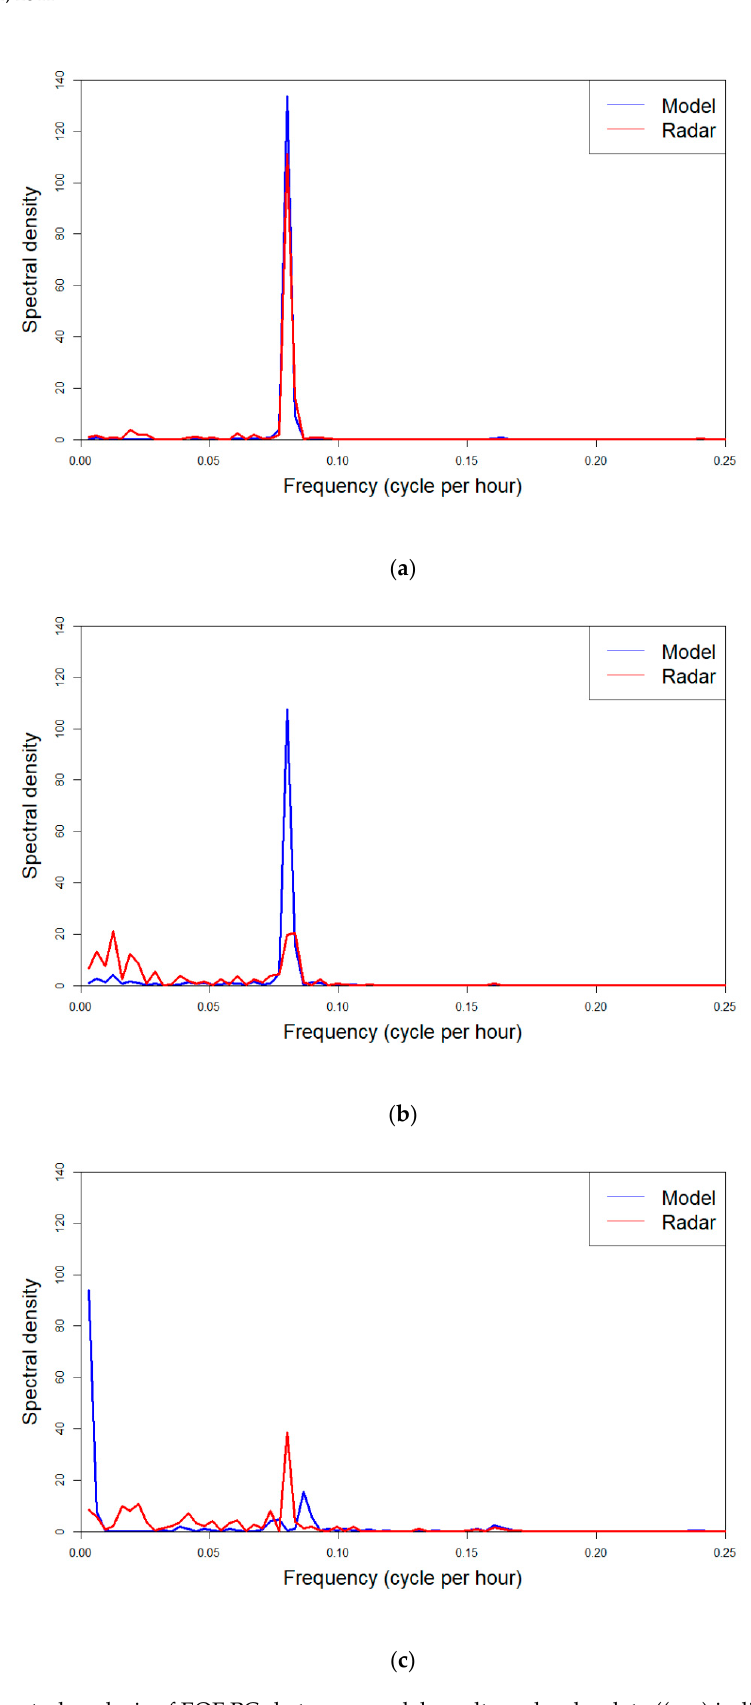
Figure 12. Spectral analysis of EOF PCs between model results and radar data (( a – c ) indicate spectral analysis for EOF PC1, PC2, and PC3,